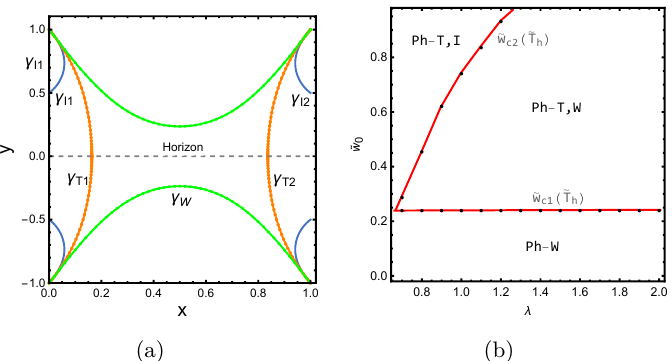
Figure 11 . (a): different configurations of HRT surfaces at ˜ t = 0 , with { L, θ 1 , θ 2 , ˜ µ, λ, ˜ w 0 } = { 1 , 3 π/ 16 , 3 π/ 16 , 0 , 2 , 3 π/ 2 } . (b): different types during evolution, with { L, θ 1 , θ 2 , ˜ µ } = { 1 , 3 π/ 16 , 3 π/ 16 , 0 } . Green dots represent that the system undergoes Ph- T,I during evolution. Orange dots represent the system undergoes Ph- T,W . While Blue dots represent the system always stays in Ph- W